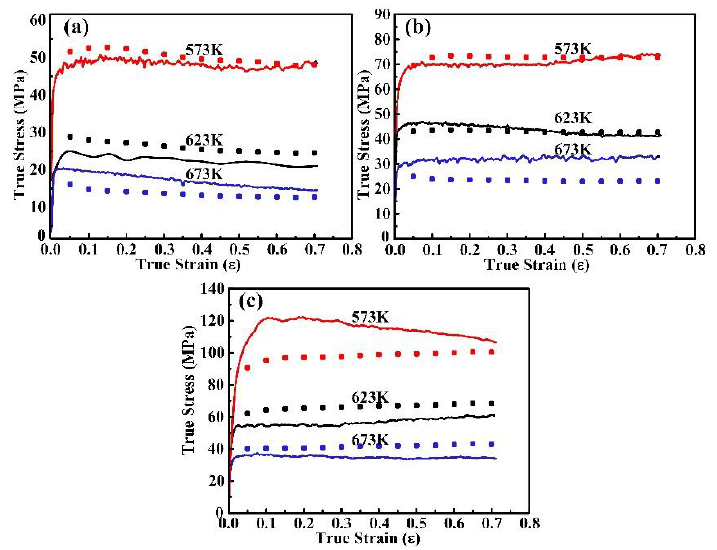
Figure 7. Measured and calculated flow stresses of as-extruded Mg–6Zn–5Ca–3Ce alloy fabricated by RS under various deformation conditions: ( a ) 0.0001 s − 1 ; ( b ) 0.001 s − 1 and ( c ) 0.01 s − 1